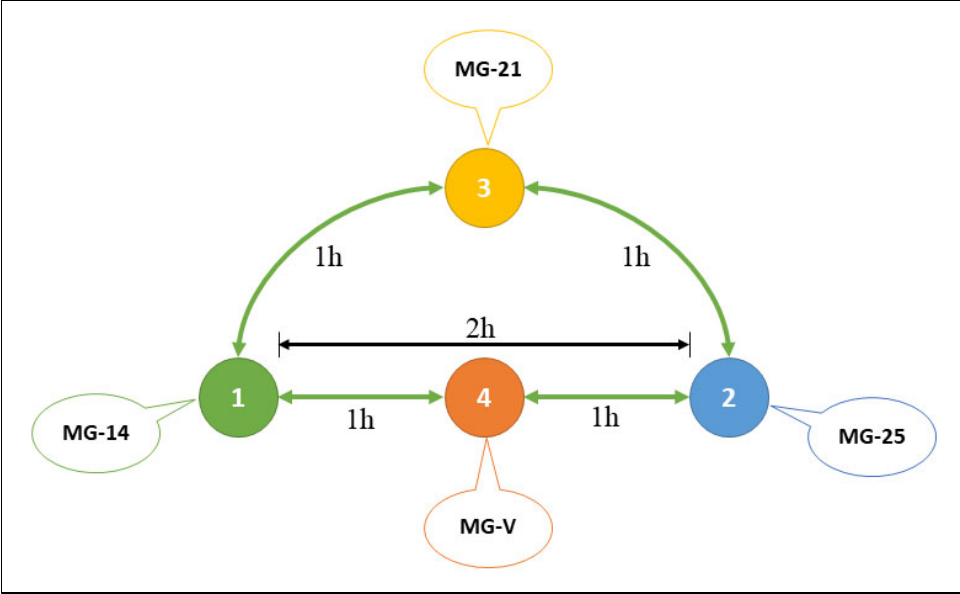
Figure 2. Virtual nodes in a transportation network.